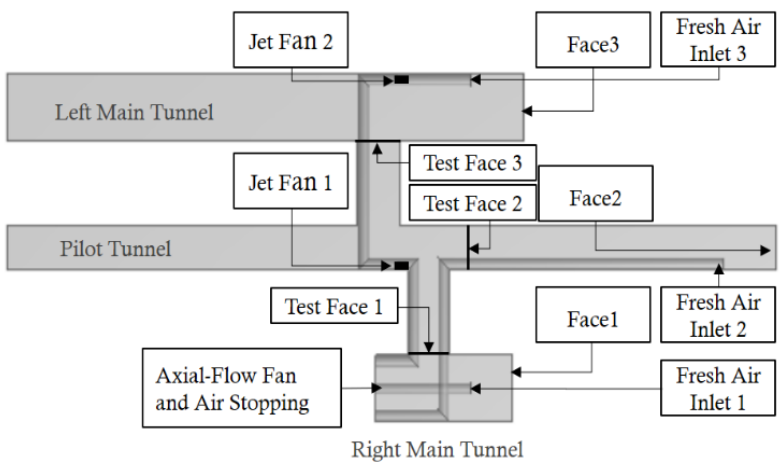
Figure 10. Calculation model.